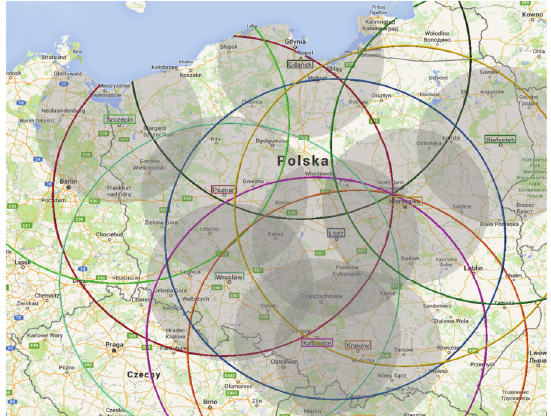
Fig. 5. Penetration area of cars using fuel cells based on 9 hydrogen refuel- ling stations situated on the national TEN-T road network by the 2030 [3] a) when driving in one direction (diameter of large circles – to approx. 600 km), b) when driving there and back (diameter of small, shaded circles – to approx. 300 km)